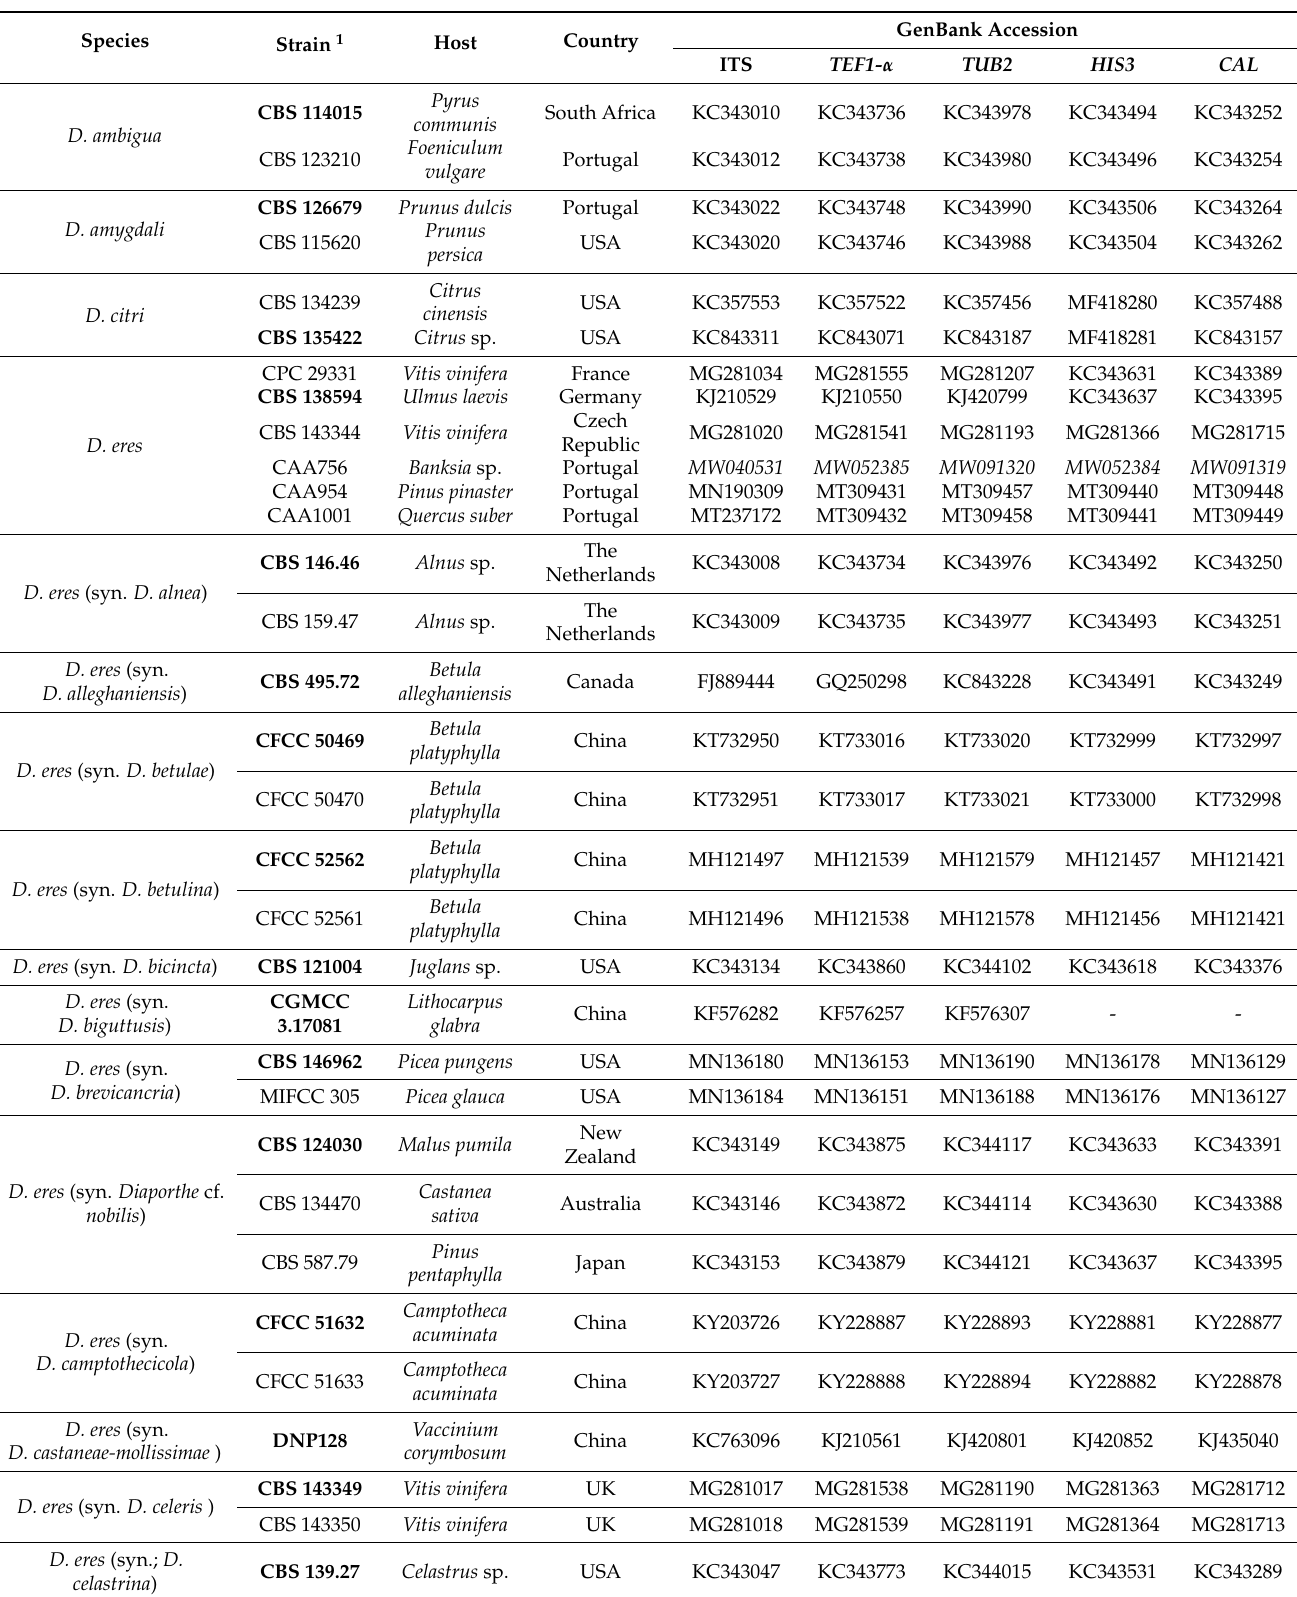
Table 1. List of Diaporthe species used in this